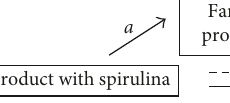
Figure 2: Model of a new product’s acceptance mediated by the familiarity with the product